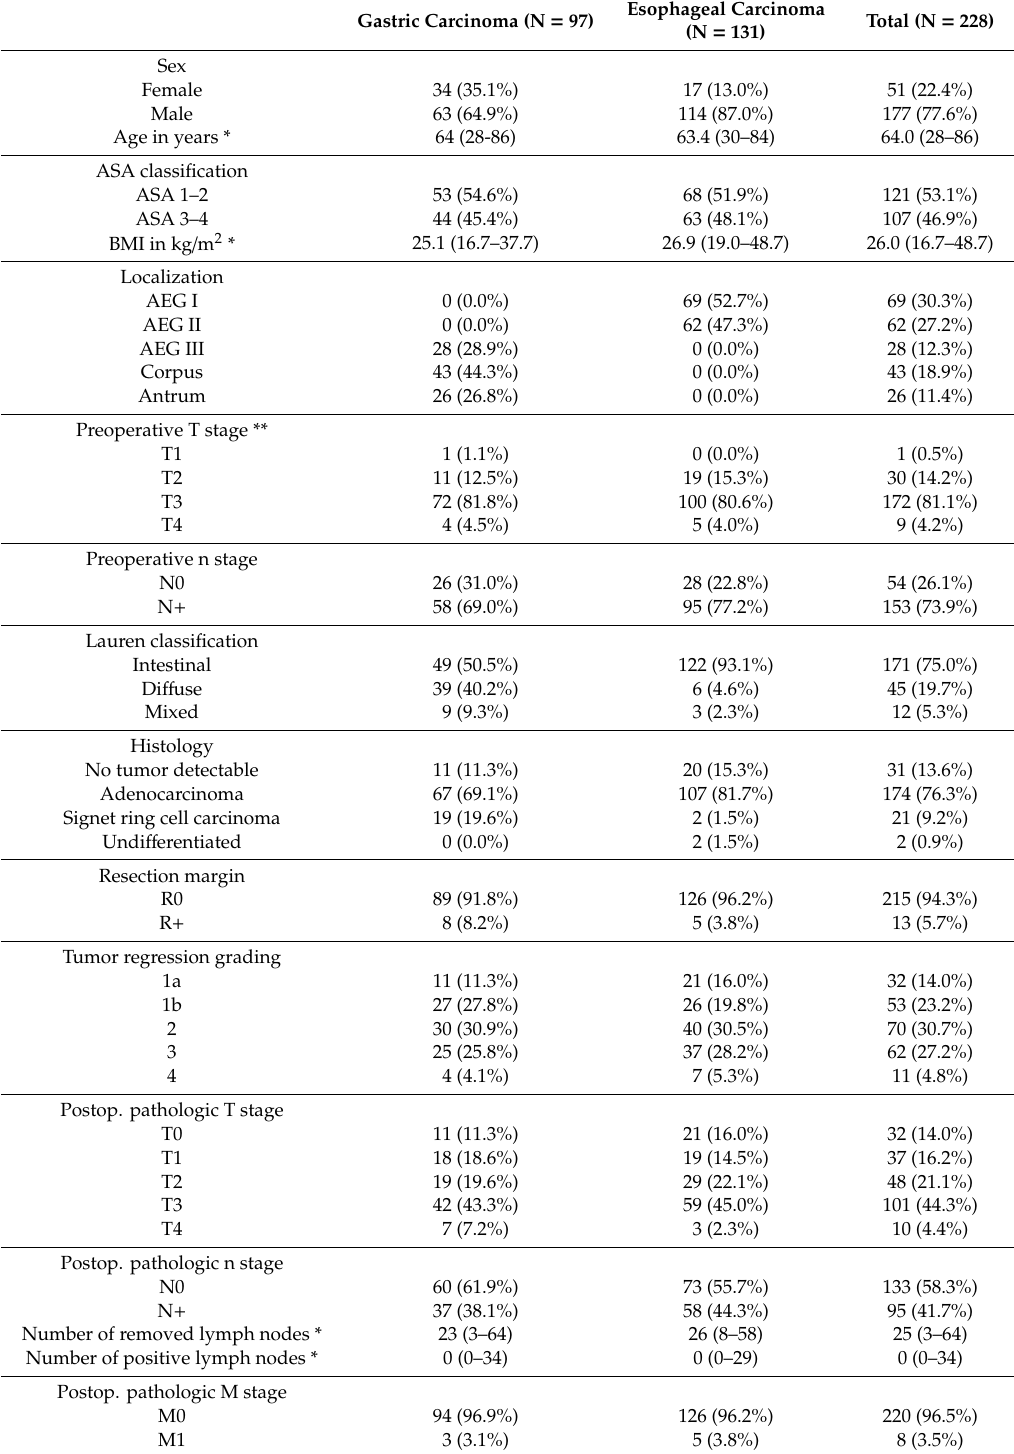
Table 1. Demographic, tumor and treatment